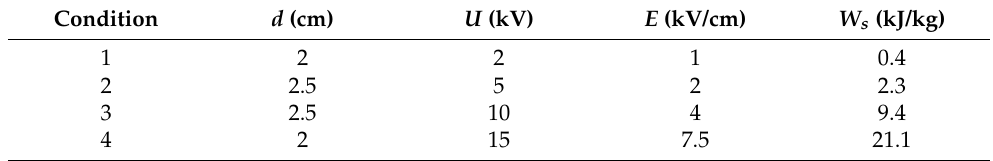
Table 2. PEF protocol applied to the EO extraction of thyme, f = 10 Hz, τ = 10 µ s, and n = 10 pulses.